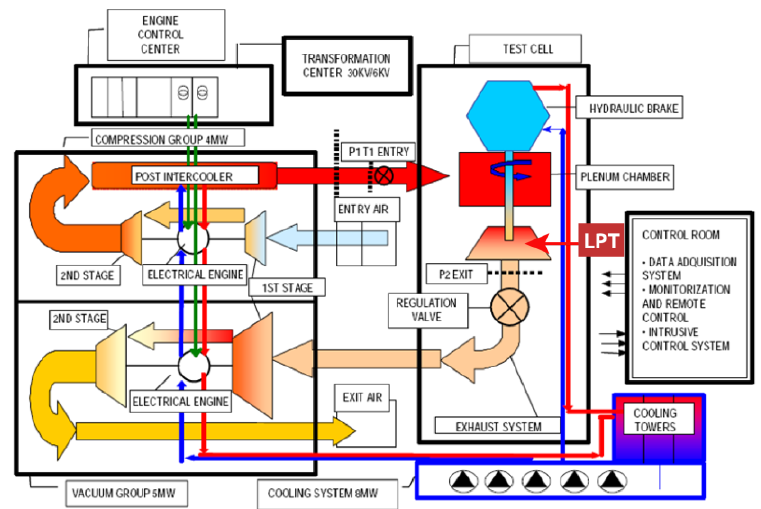
Figure 1. Scheme of the transonic test turbine facility. The disk under test was assembled in the position where the low-pressure turbine (LPT) is usually placed.